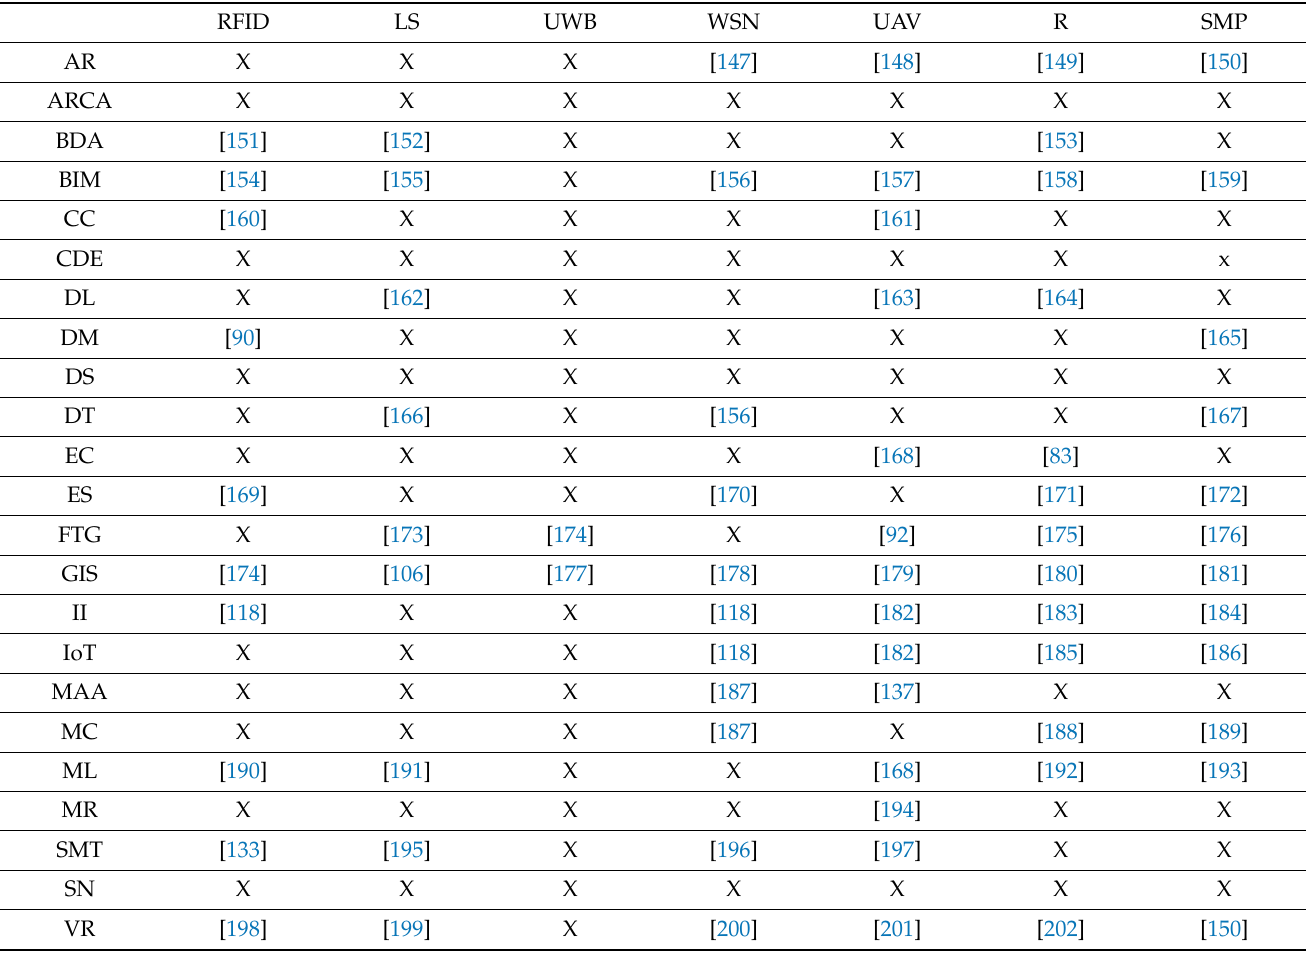
Table 10. Integration matrix between field data capture and communication and collaboration technologies—inter-FDCT and -CT.